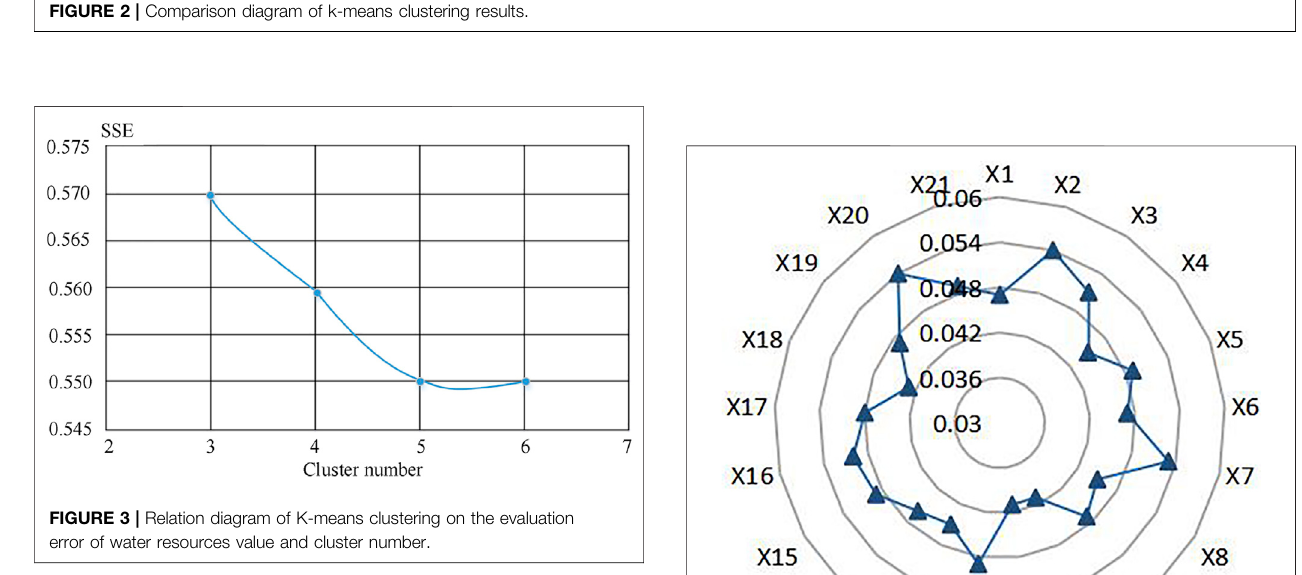
FIGURE 2 | Comparison diagram of k-means clustering results.